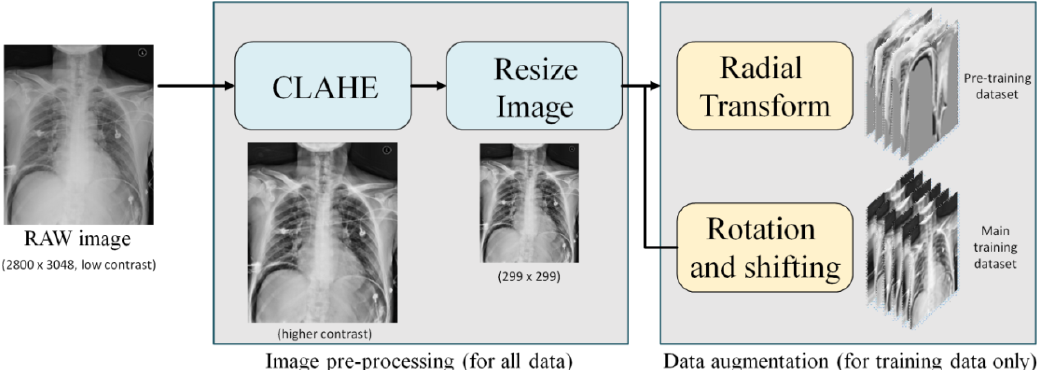
Figure 3. The flowchart of data